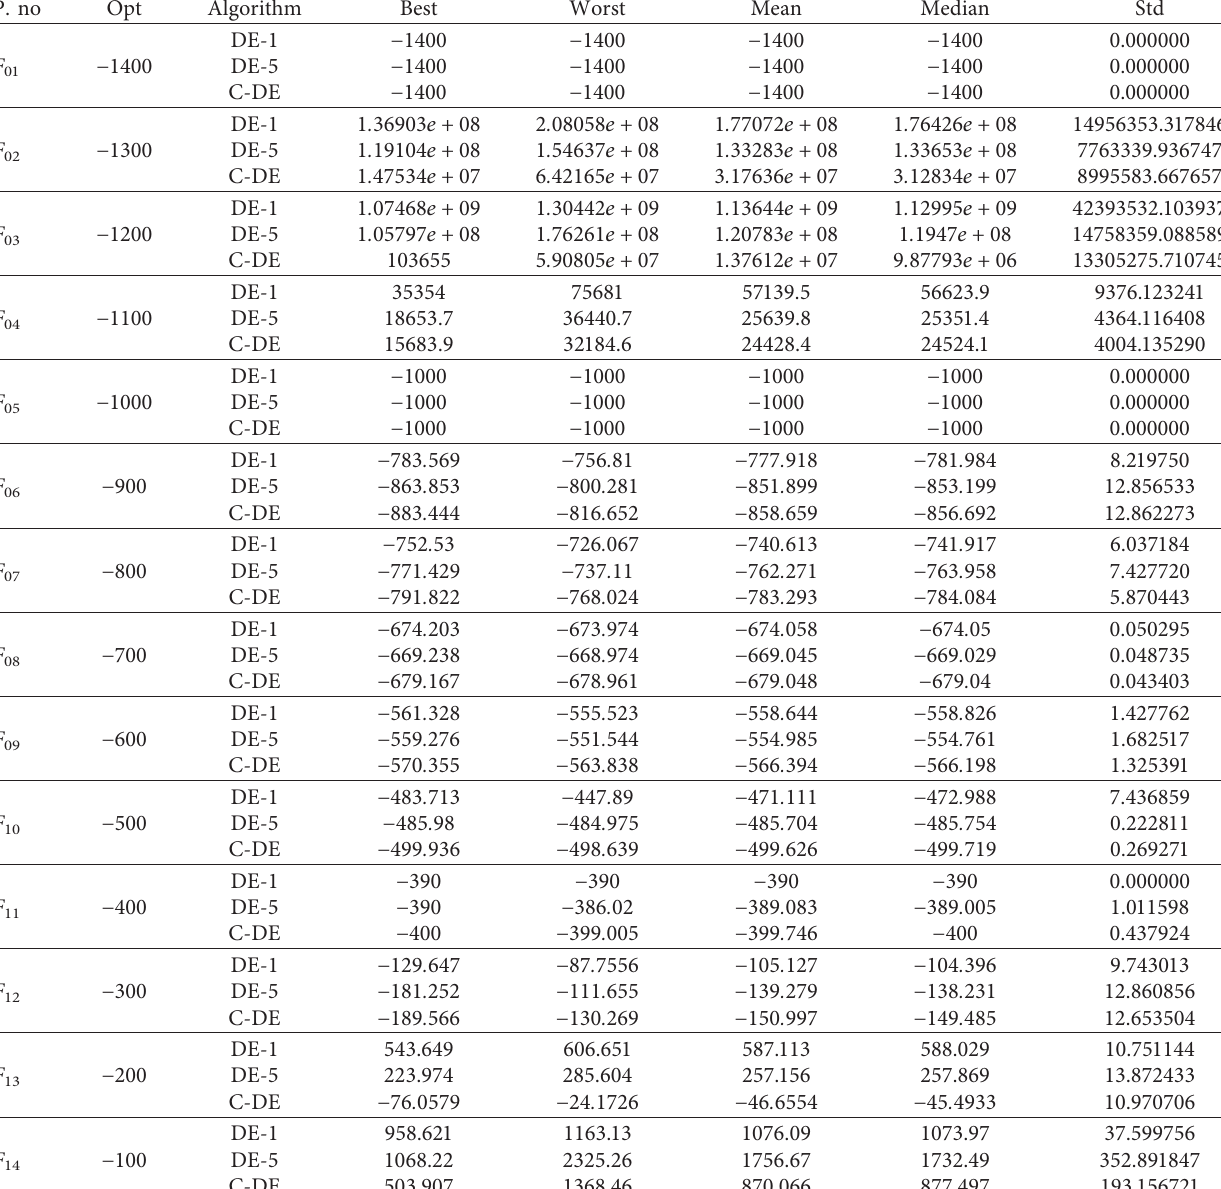
Table 4: The experimental results obtained by DE-1 and DE-5 versus proposed C-DE by solving CEC’13 benchmark functions F n � 30 dimensions. P.